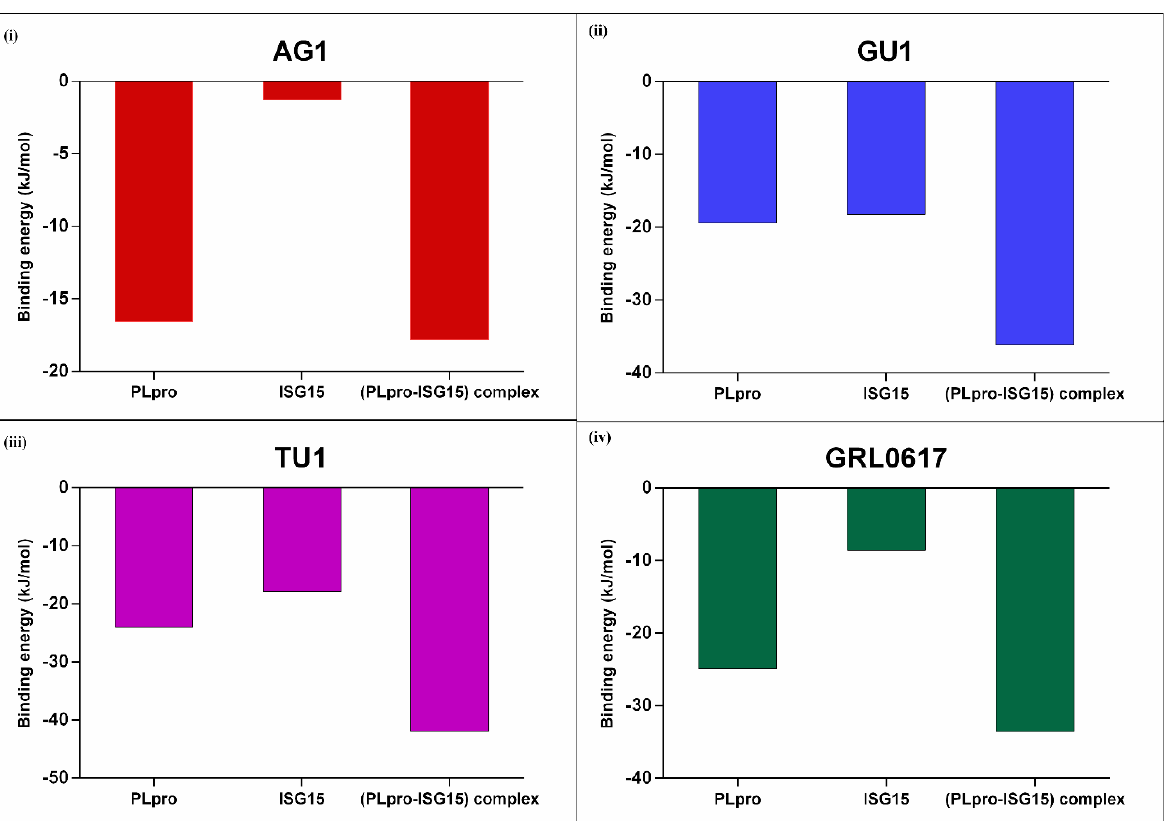
Figure 6. Binding energies (kJ/mol) of the complexes were calculated by MMPBSA method. Key interacting residues from PLpro or ISG15 or (PLpro-ISG15) complexes were considered for calculating binding energy for AG1 ( i ), GU1 ( ii ), TU1 ( iii ) and GRL0617 ( iv ).